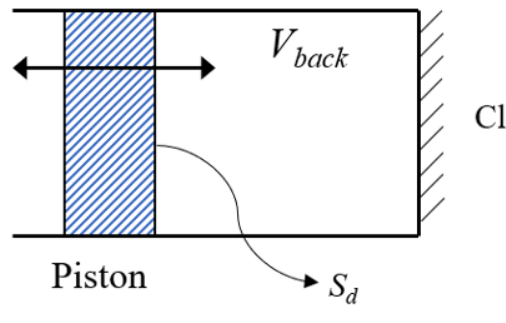
Figure 5. Piston source model.